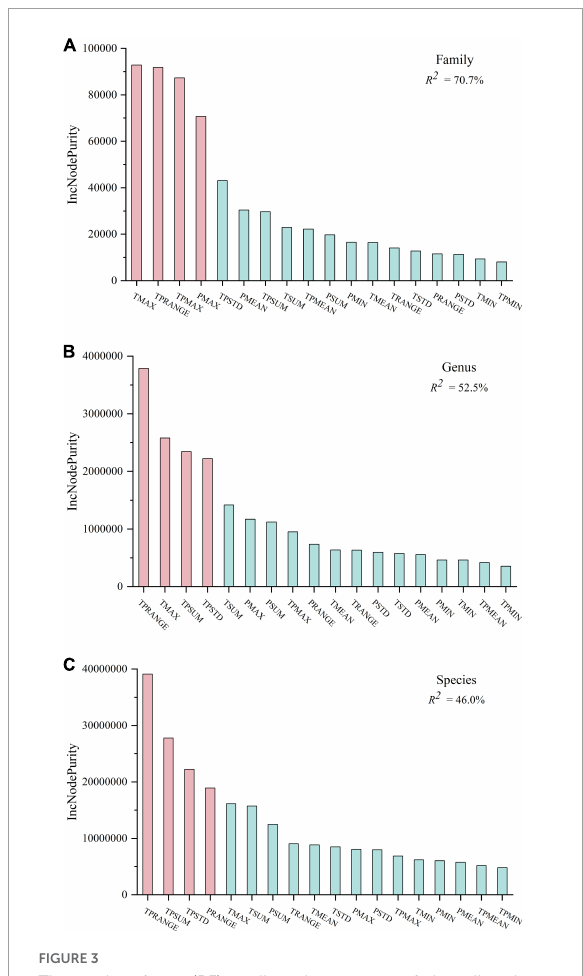
FIGURE3 The random forest (RF) predictor importance of plant diversity distribution patterns at family (A) , genus (B) , and species (C) . Significance levels are as follows: red represents P < 0.05 and blue represents P > 0.05. TMIN, minimum accumulated temperature; TMAX, the maximum accumulated temperature; TMEAN, mean of accumulated temperature; TRANGE, the range of accumulated temperature; TSTD, the standard deviation of accumulated temperature; TSUM, the sum of accumulated temperature. PMIN, minimum value of annual precipitation; PMAX, the maximum annual precipitation; PMEAN, mean of average annual precipitation; PRANGE, the range of annual mean precipitation; PSTD, the standard deviation of annual precipitation; PSUM: the sum of the average annual precipitation. TPMIN: minimum value of hydrothermal